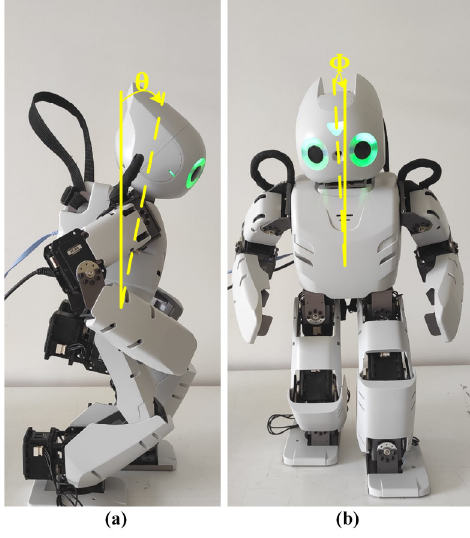
Figure 8. Body tilt angles: ( a ) pitch angle, ( b ) roll angle.